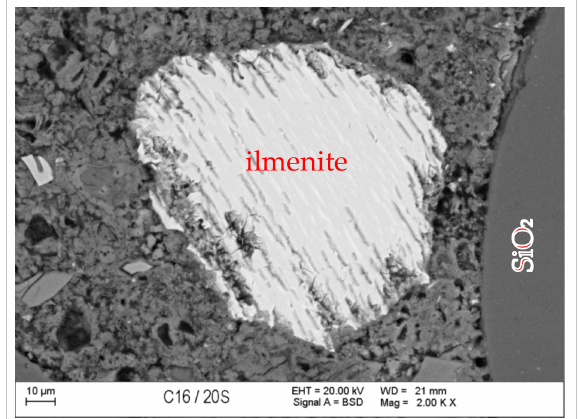
Figure 15. BSE image of RMUD concrete